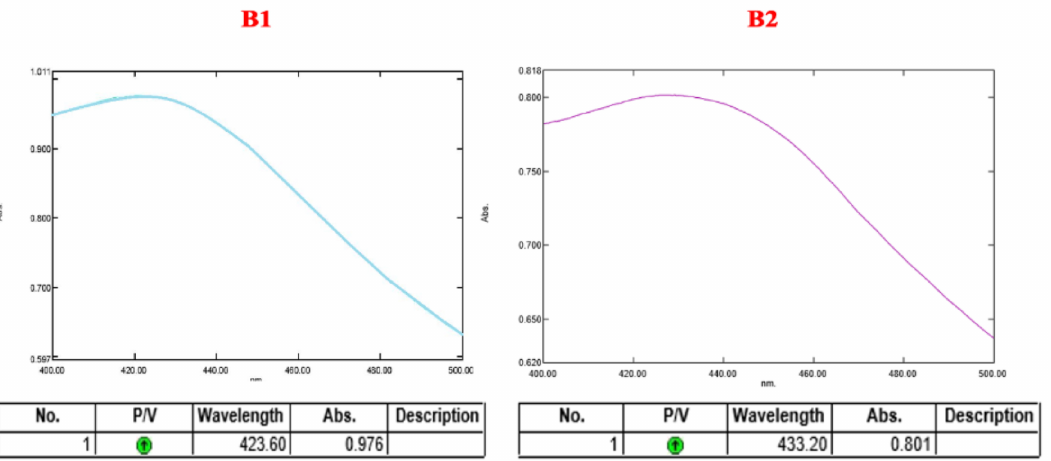
Figure 2. UV-Vis Spectra of nanoconjugates formed from ( B1 ) aqueous extract and ( B2 ) methanolic extract.